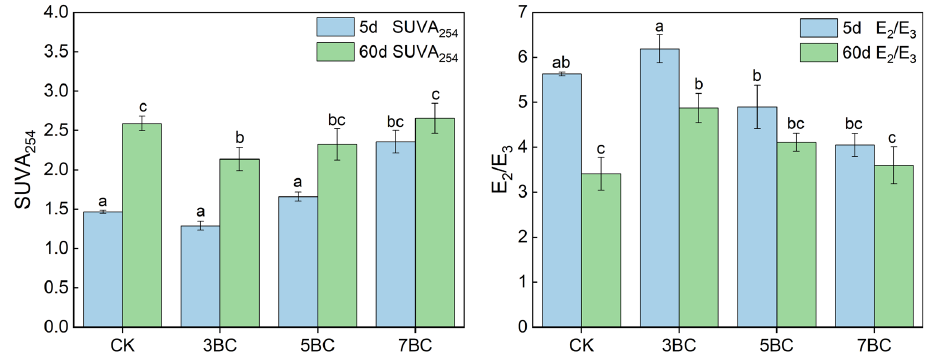
Figure 3. SUVA 254 and E 2 /E 3 of DOM in soil treated with biochar at different incubation times (5 d and 60 d). Data are presented as mean ± standard deviation (SD), n = 3. Different letters indicate significant differences between treatments of the soil (one-way ANOVA, p < 0.05), respectively. CK, control; 3BC, 300 ◦ C biochar treatment; 5BC, 500 ◦ C biochar treatment; 7BC, 700 ◦ C biochar treatment.